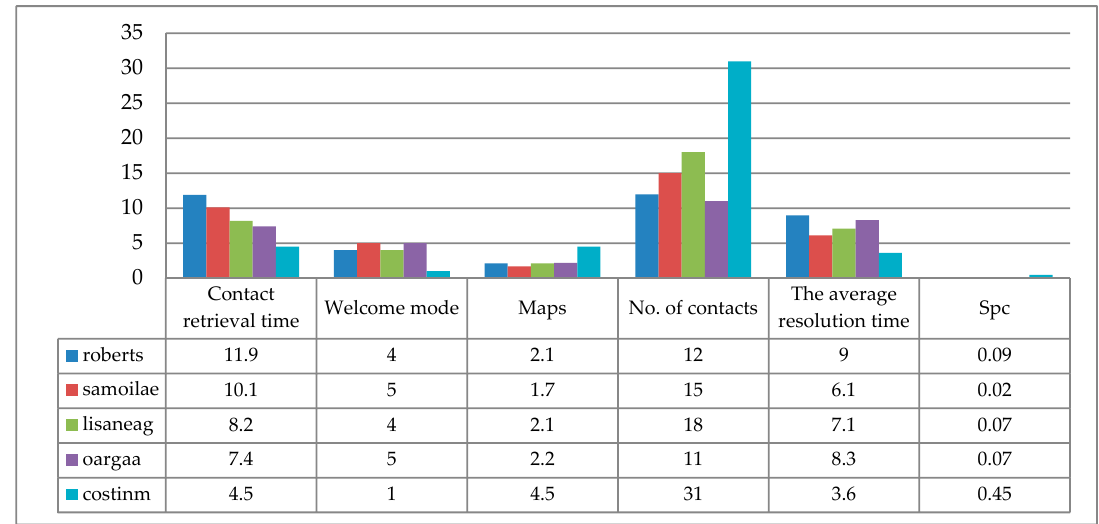
Figure 1. Status of the MS assessment of employees related to the best Spc obtained.